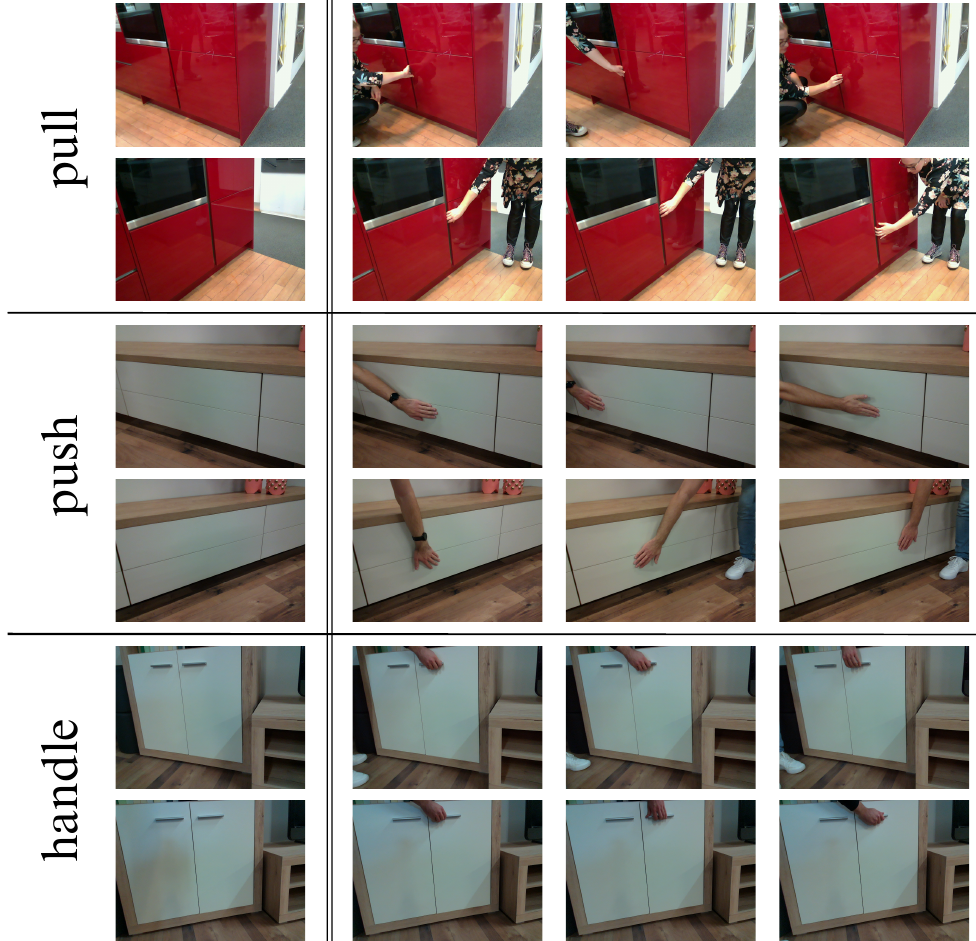
Figure 4. Sample images from our dataset representing the three types of handling considered. Left : Baseline images of the same object captured from different viewpoints. Right : Images with a human demonstrating the type of opening. The images in each row correspond with the baseline image on the left.